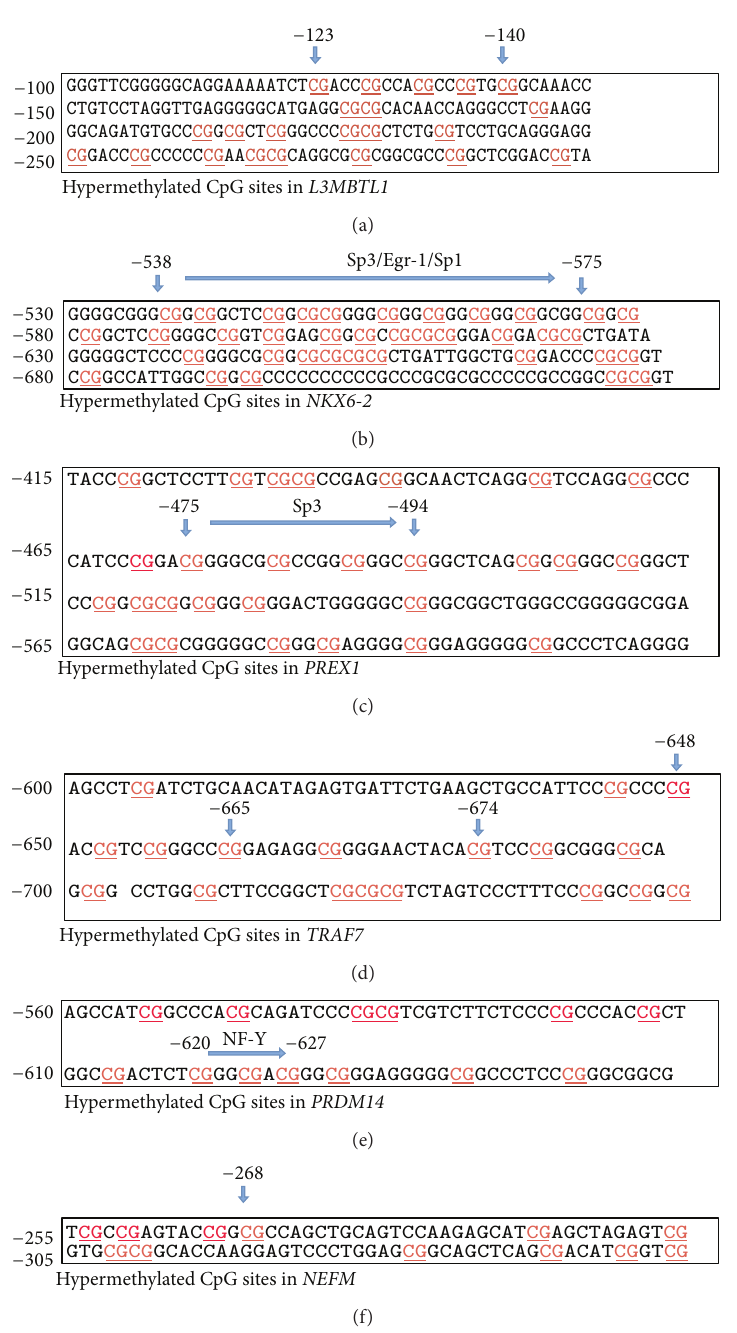
Figure 1: DNA methylation profile of RRBS analyzed hypermethylated genes in the tumor samples of African American patients: L3MBTL1 (a), NKX6-2 (b), PREX1 (c), TRAF7 (d), PRDM14 (e), and NEFM